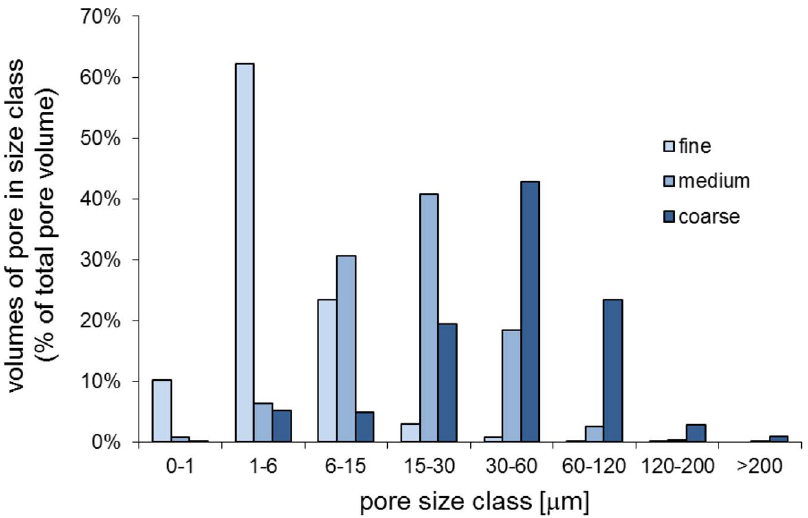
Figure 2. Pore size distribution of the three sand size fractions (fine, medium, coarse). Boxes indicate water-filled pores at different matric potentials, i.e. in the ‘‘dry’’ treatments all pores with a pore-neck diameter , =6 m m are filled with water, in the ‘‘intermediate’’ treatments , =15 m m and in the ‘‘wet’’ treatments , =30 m m, respectively. Pores above these pore-neck diameters are filled with air.